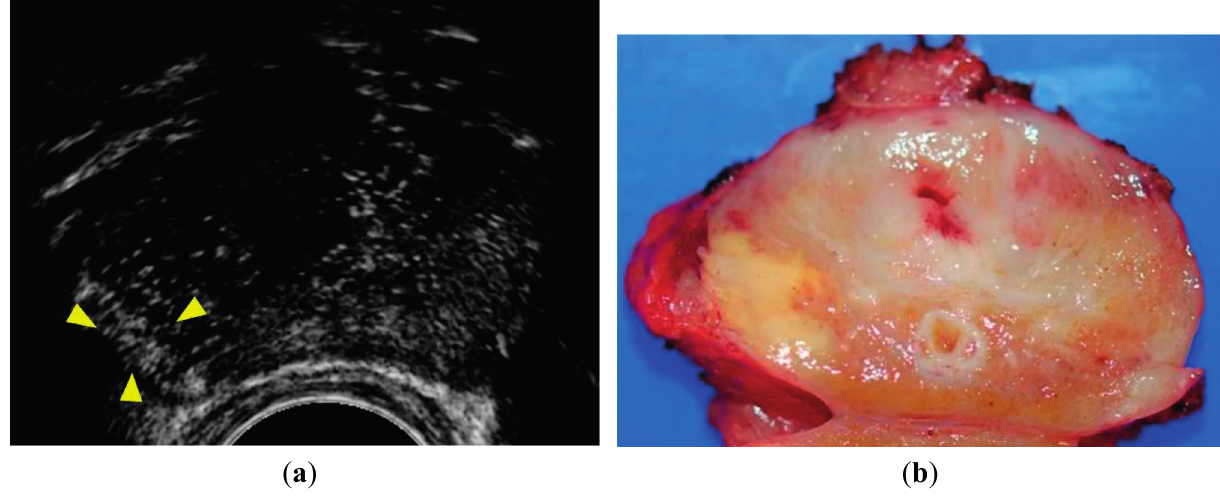
Figure 1. Patient with a PSA level of 16.2 ng/mL. ( a ) CEUS showed rapid contrast enhancement in the peripheral zone of the right lobe (arrowheads); ( b ) Surgical specimen of the case shown in this case. A yellow tumor was shown in the right lobe in agreement with the enhancement of the lesion. Pathological examination revealed that the tumor was a Gleason 3 + 4